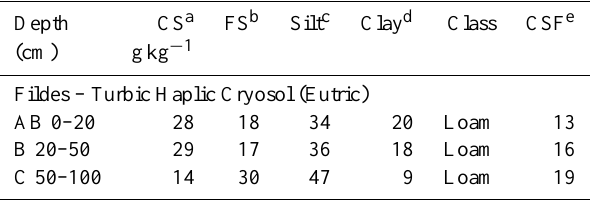
Table 2. Soil texture of the studied profile.